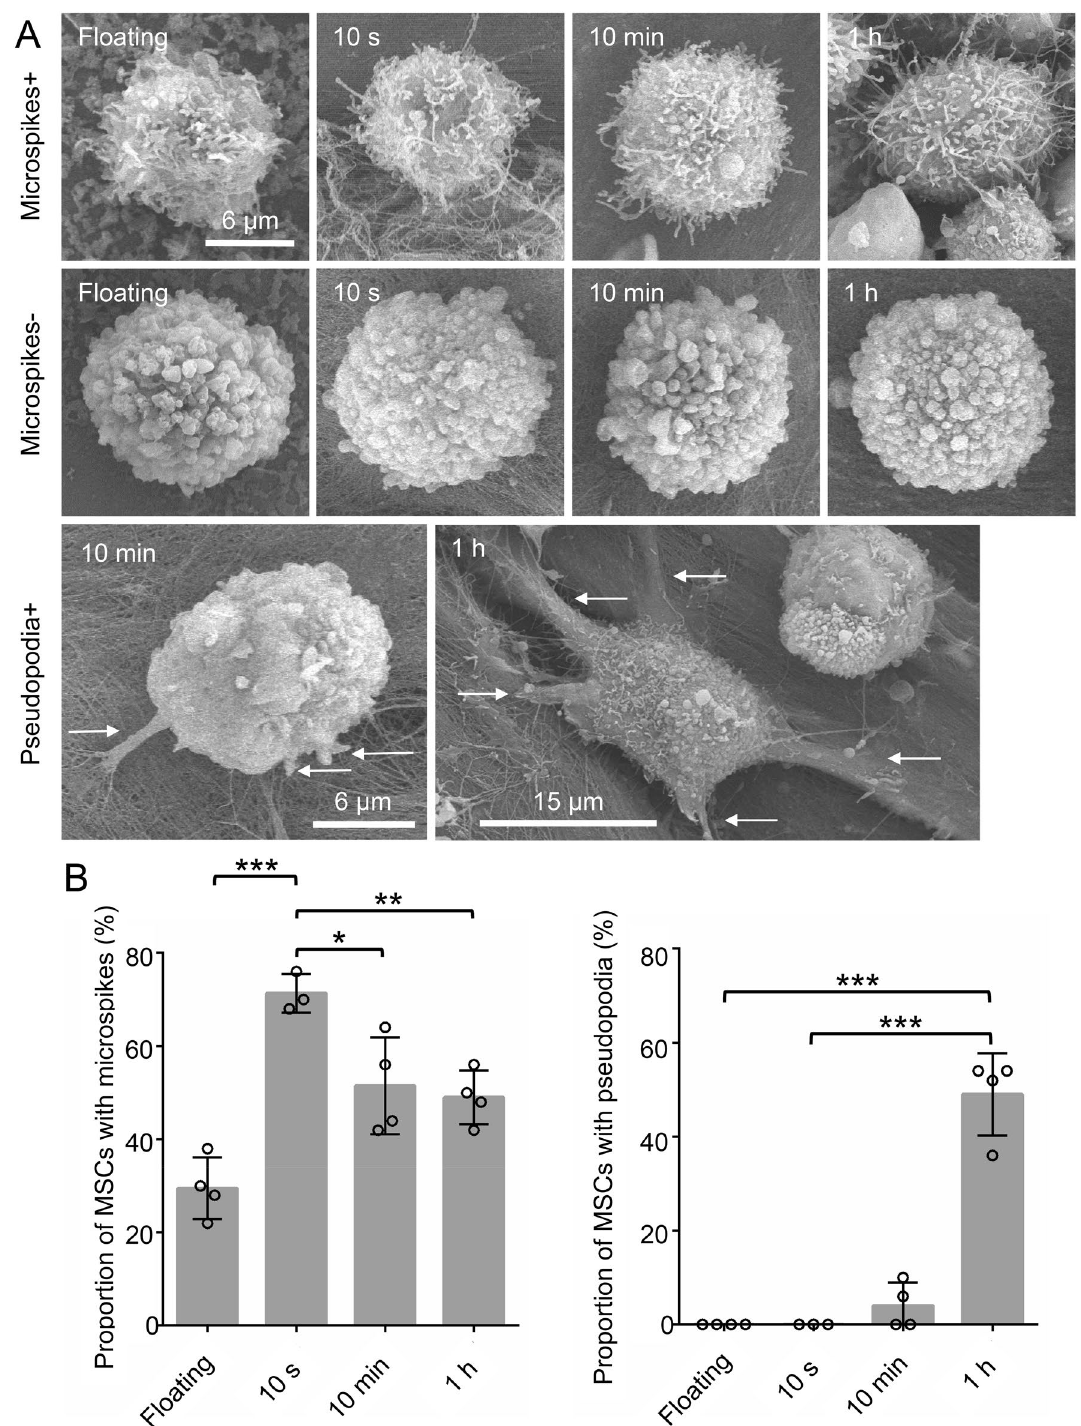
Figure 6. Scanning electron microscopy observation and quantification of microspikes and pseudopodia in adhered MSCs. ( A ) Representative SEM images of MSCs with microspikes and pseudopodia. The pseudopodia are indicated by arrows. ( B ) Quantification of MSCs with microspikes and with pseudopodia. Fifty MSCs were observed per MSC donor. This experiment was repeated 3 or 4 times independently and plotted. Data are also expressed as the average ± standard deviation (* p < 0.05, ** p < 0.01, *** p <